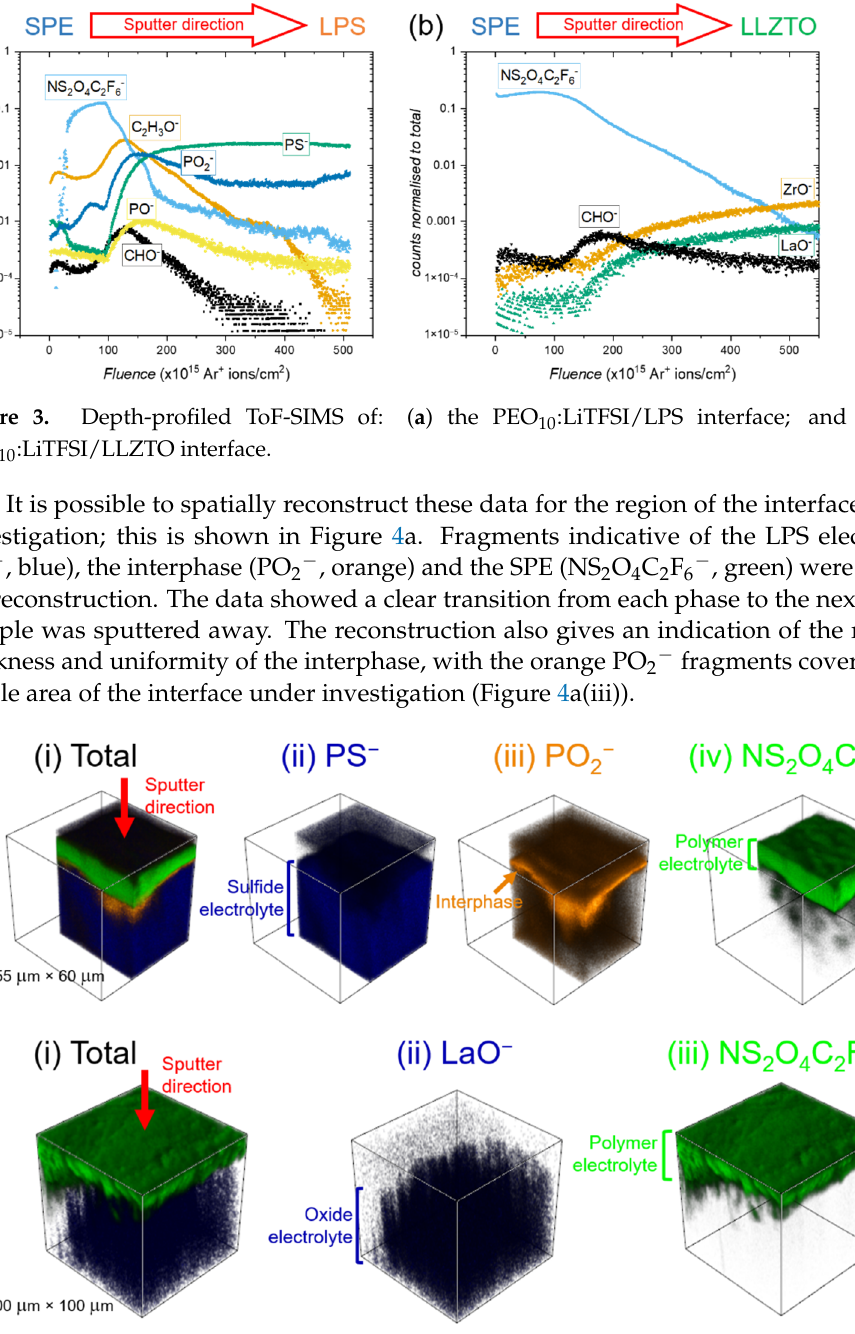
Figure 4. ToF-SIMS reconstructions of ( a ) the PEO 10 :LiTFSI/LPS interface, showing: ( i ) the total reconstruction, ( ii ) PS − fragments (blue), ( iii ) PO 2− fragments (orange) and ( iv ) NS 2 O 4 C 2 F 6− fragments (green); and ( b ) the PEO 10 :LiTFSI/LLZTO interface: ( i ) the total reconstruction, ( ii ) LaO − fragments (blue) and ( iii ) NS 2 O 4 C 2 F 6− fragments (green).